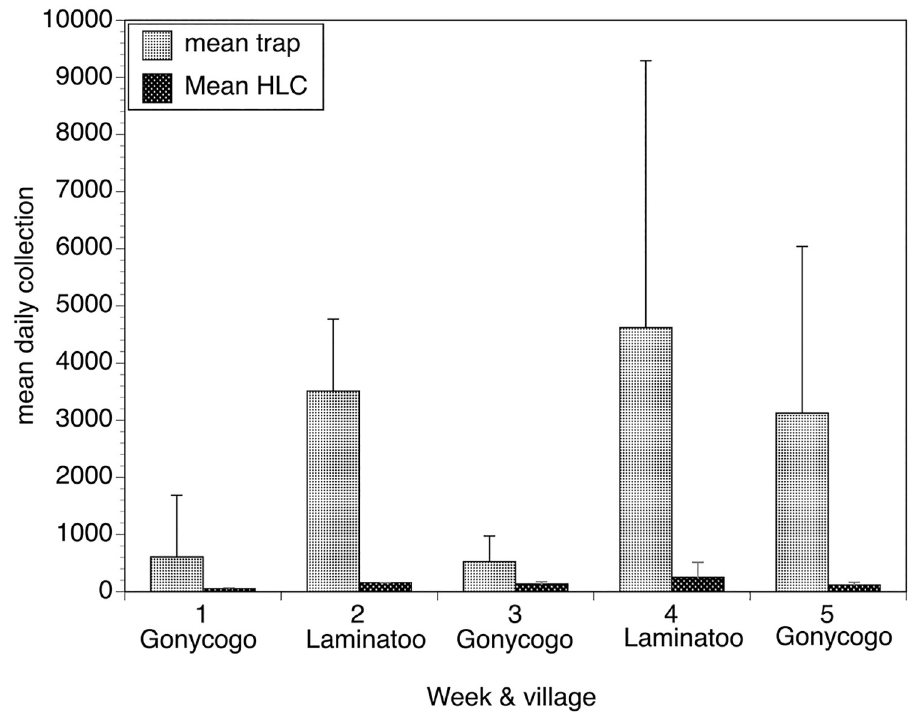
Fig 7. Daily collections obtained by traps and by the human landing collector located in the fields of Gonycogo and Laminatoo. Bars represent the mean daily collection obtained by each of the five individual traps situated around the two fields in each village and the mean collection obtained by the two HLCs situated in each field over the five weeks of the study. Error bars depict the standard deviation surrounding the mean daily collections. Data from each week were calculated from six days of human collection data and 30 days of trap collection data. Raw collection data for this study may be found in the S6 Table.